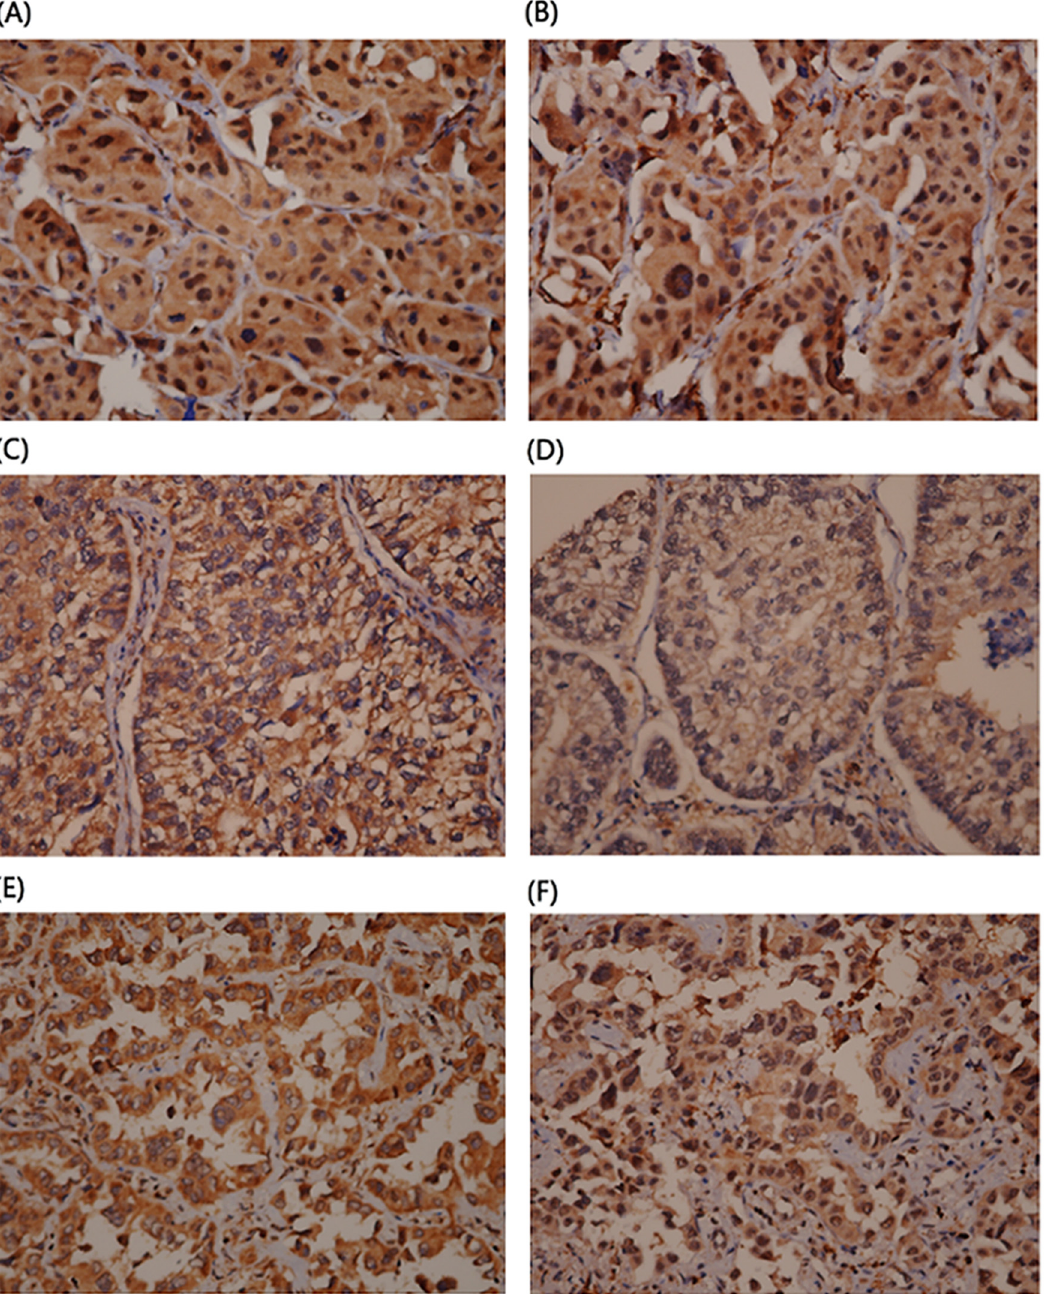
Fig 1. Representative IHC staining of FEN1 and RAD54B in lung adenocarcinoma tissues. (a) and (b): Both positive FEN-1 and RAD54B nuclear staining; (c)and (d): Both negative FEN-1 and RAD54B nuclear staining; (e)and (f): Negative FEN-1 and positive RAD54B nuclear